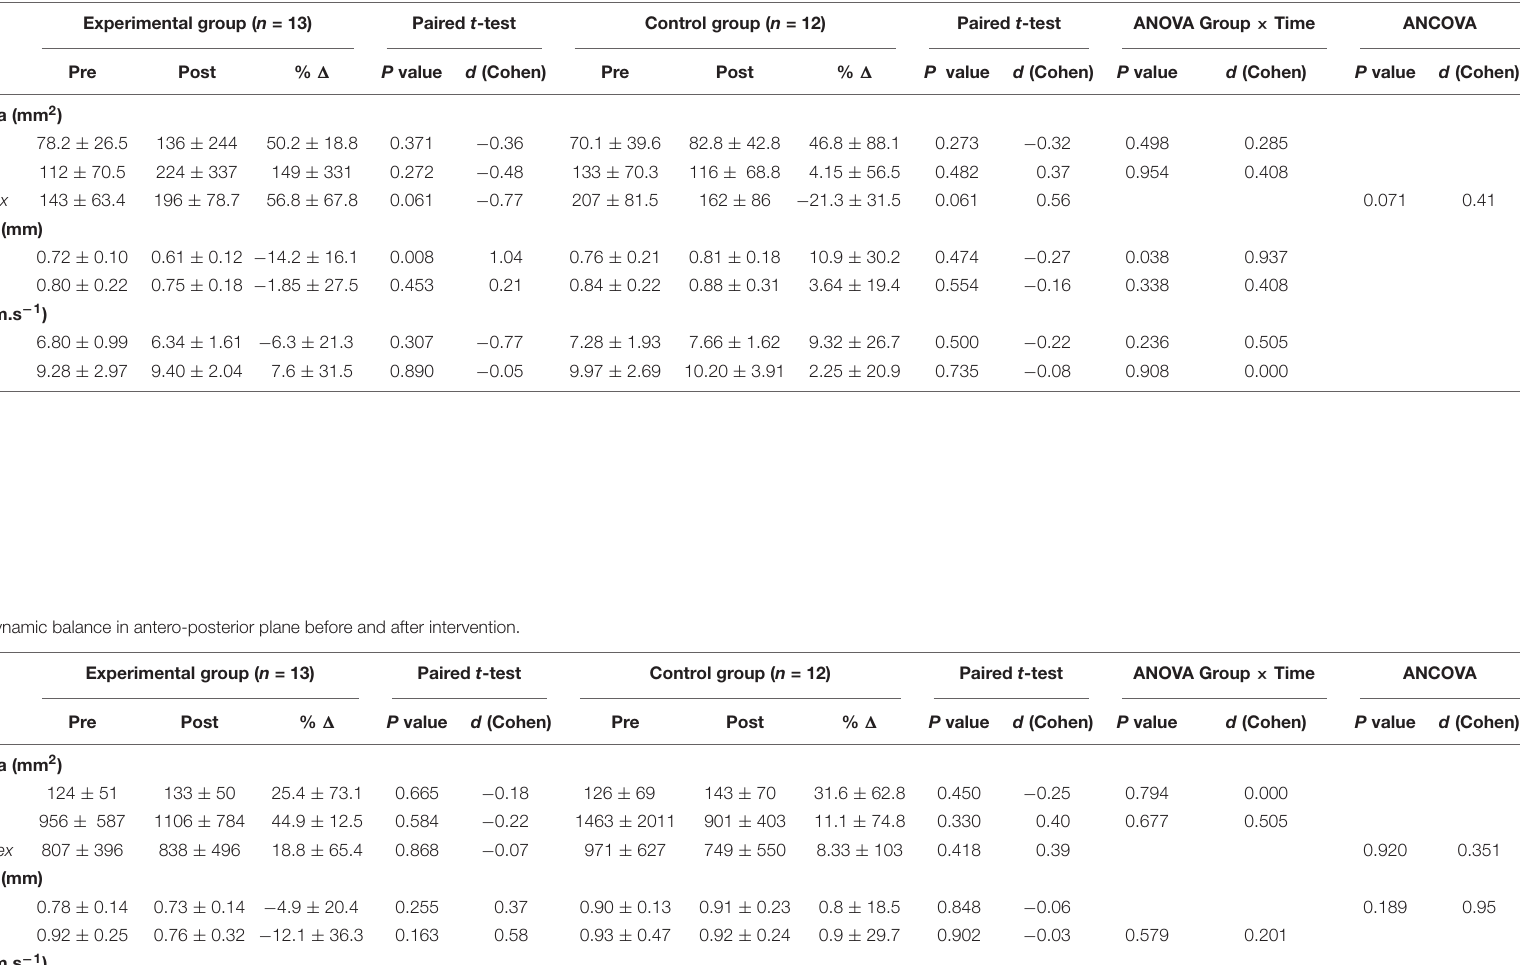
TABLE 3 | Static balance, pre-, and post-intervention.